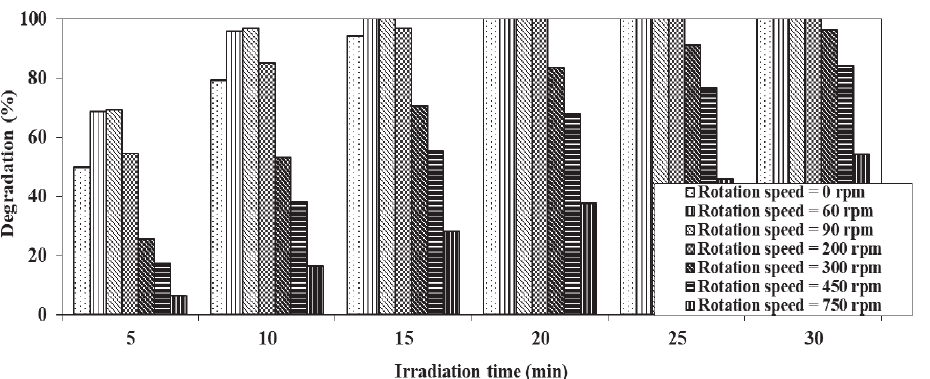
Fig. 10 – Effect of rotation speed of the spinning disc on the removal percent of PNP in the SDP. [PNP] = 20 mg L –1 , volume = Fig. 10 500 mL, pH = 5.5,